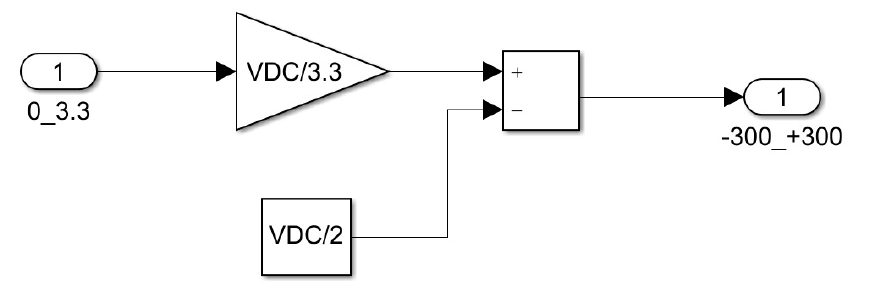
Figure 4. Simulink model of the subsystem “BRIDGE”.